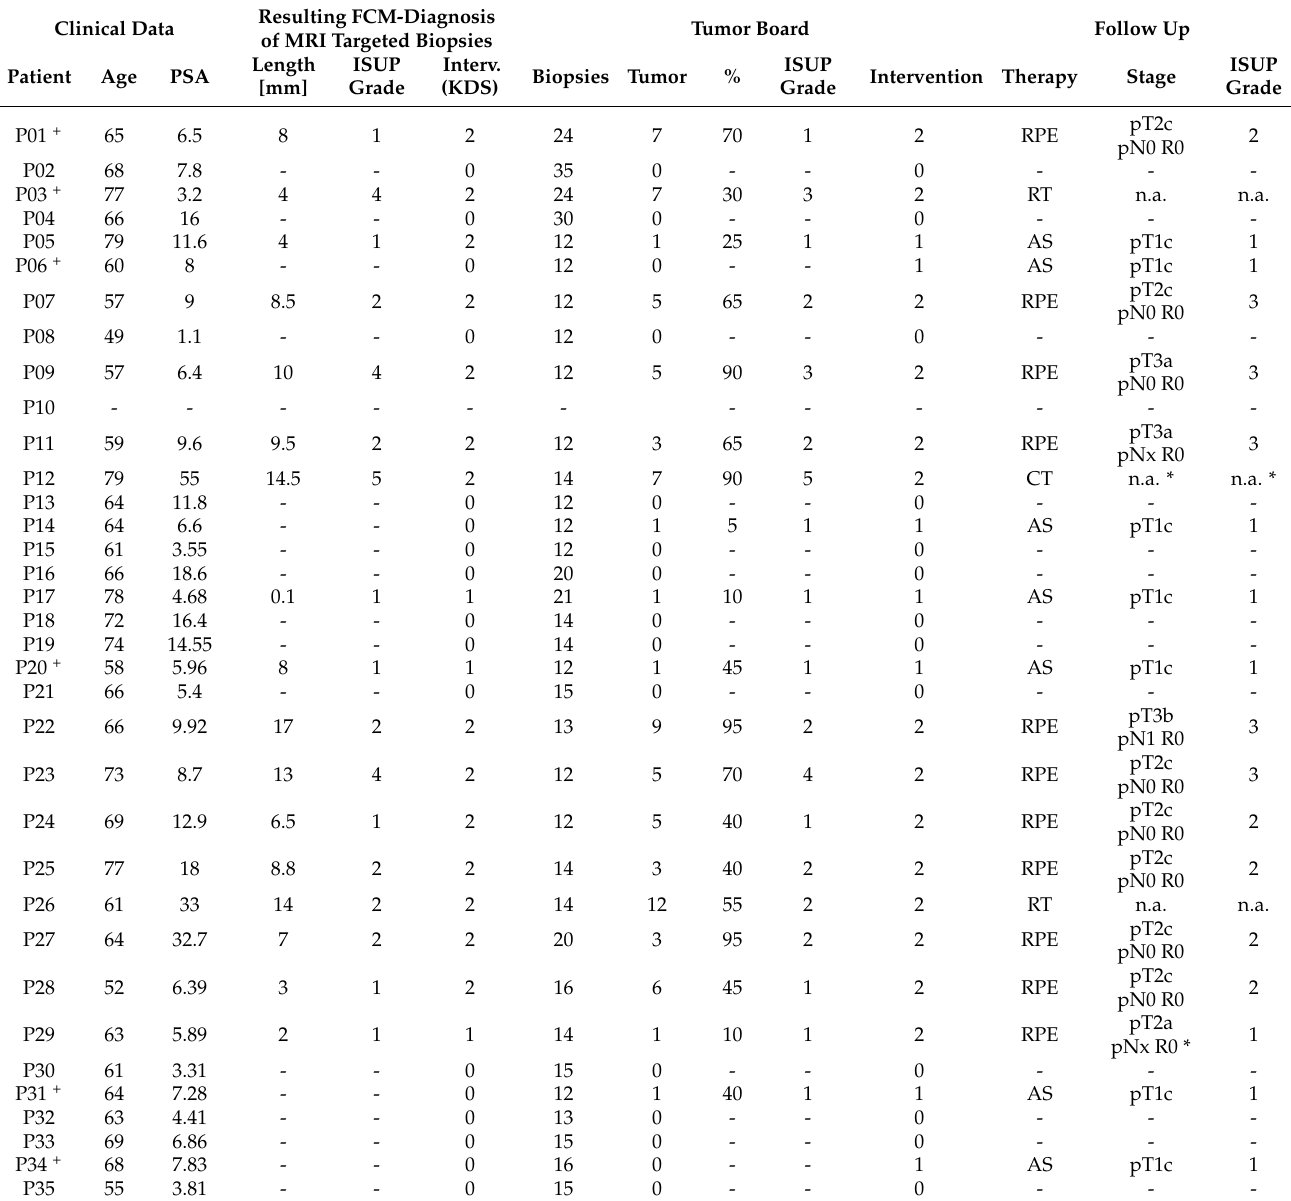
Table 2. Comparison of therapy recommendations based on the intraoperative FCM diagnoses and the tumor board combined with follow up